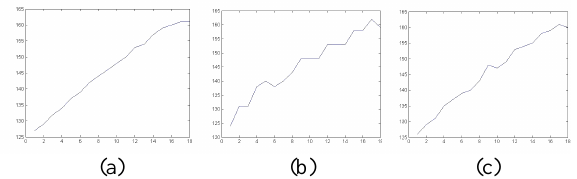
Figure 1: ground truth (a) smoothing without (b) or using (c) S sl feature on a small DSM